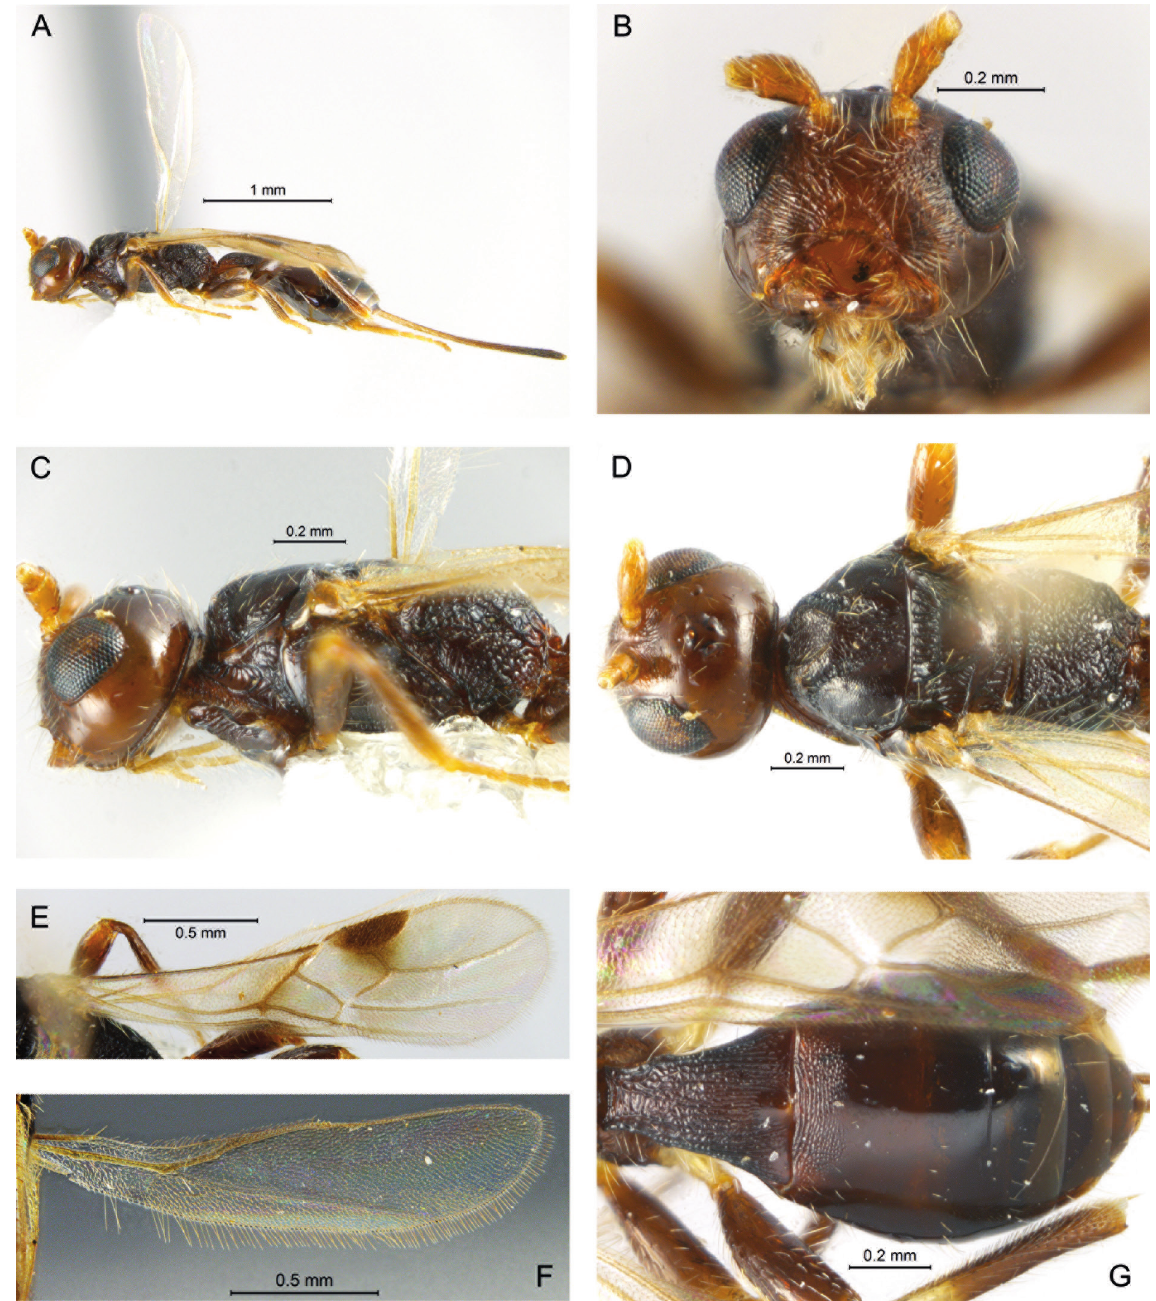
Fig. 5. Hecabolus transversalis sp. nov., ♀, holotype (NHMUK). A . Habitus, lateral view. B . Head, frontal view. C . Mesosoma, lateral view. D . Mesosoma, dorsal view. E . Fore wing. F . Hind wing. G . Metasoma, dorsal view, showing the transverse anterior striation of the second metasomal